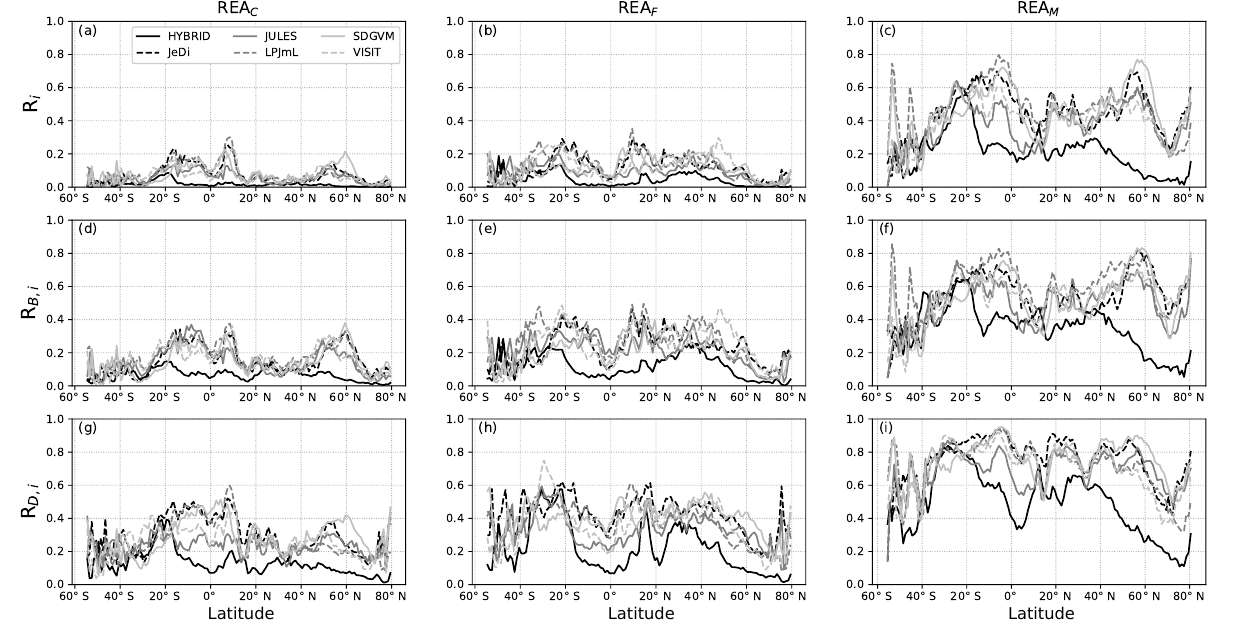
Figure 4. Zonal mean R i , R B,i and R D,i (row-wise) in each REA C , REA F and REA M (column-wise). Each line represents the average value obtained across the five simulations of each GVM.